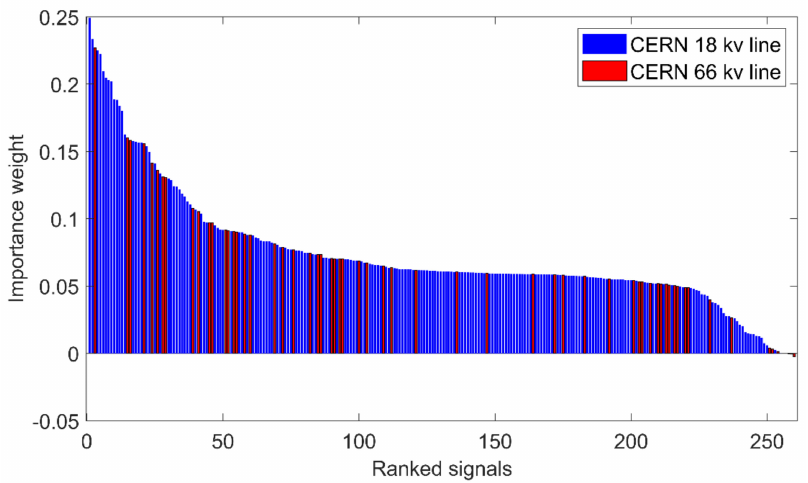
Figure 7. Relief weights and ranking for the LHC 66 kV and 18 kV monitoring